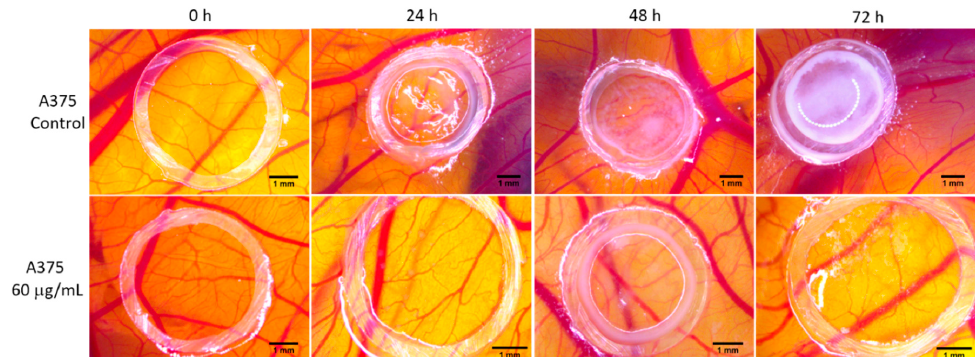
Figure 8. Tumor angiogenesis evaluation in the CAM assay using A375 melanoma cells. In ovo tumor cells were exposed to the OB extract (60 µg/mL), next to DMSO as the control; stereomicroscope photographs were recorded at 0 h, 24 h, 48 h and 72 h. CAM, chorioallantoic membrane; OB, Oenothera biennis ; DMSO, dimethyl sulfoxide.